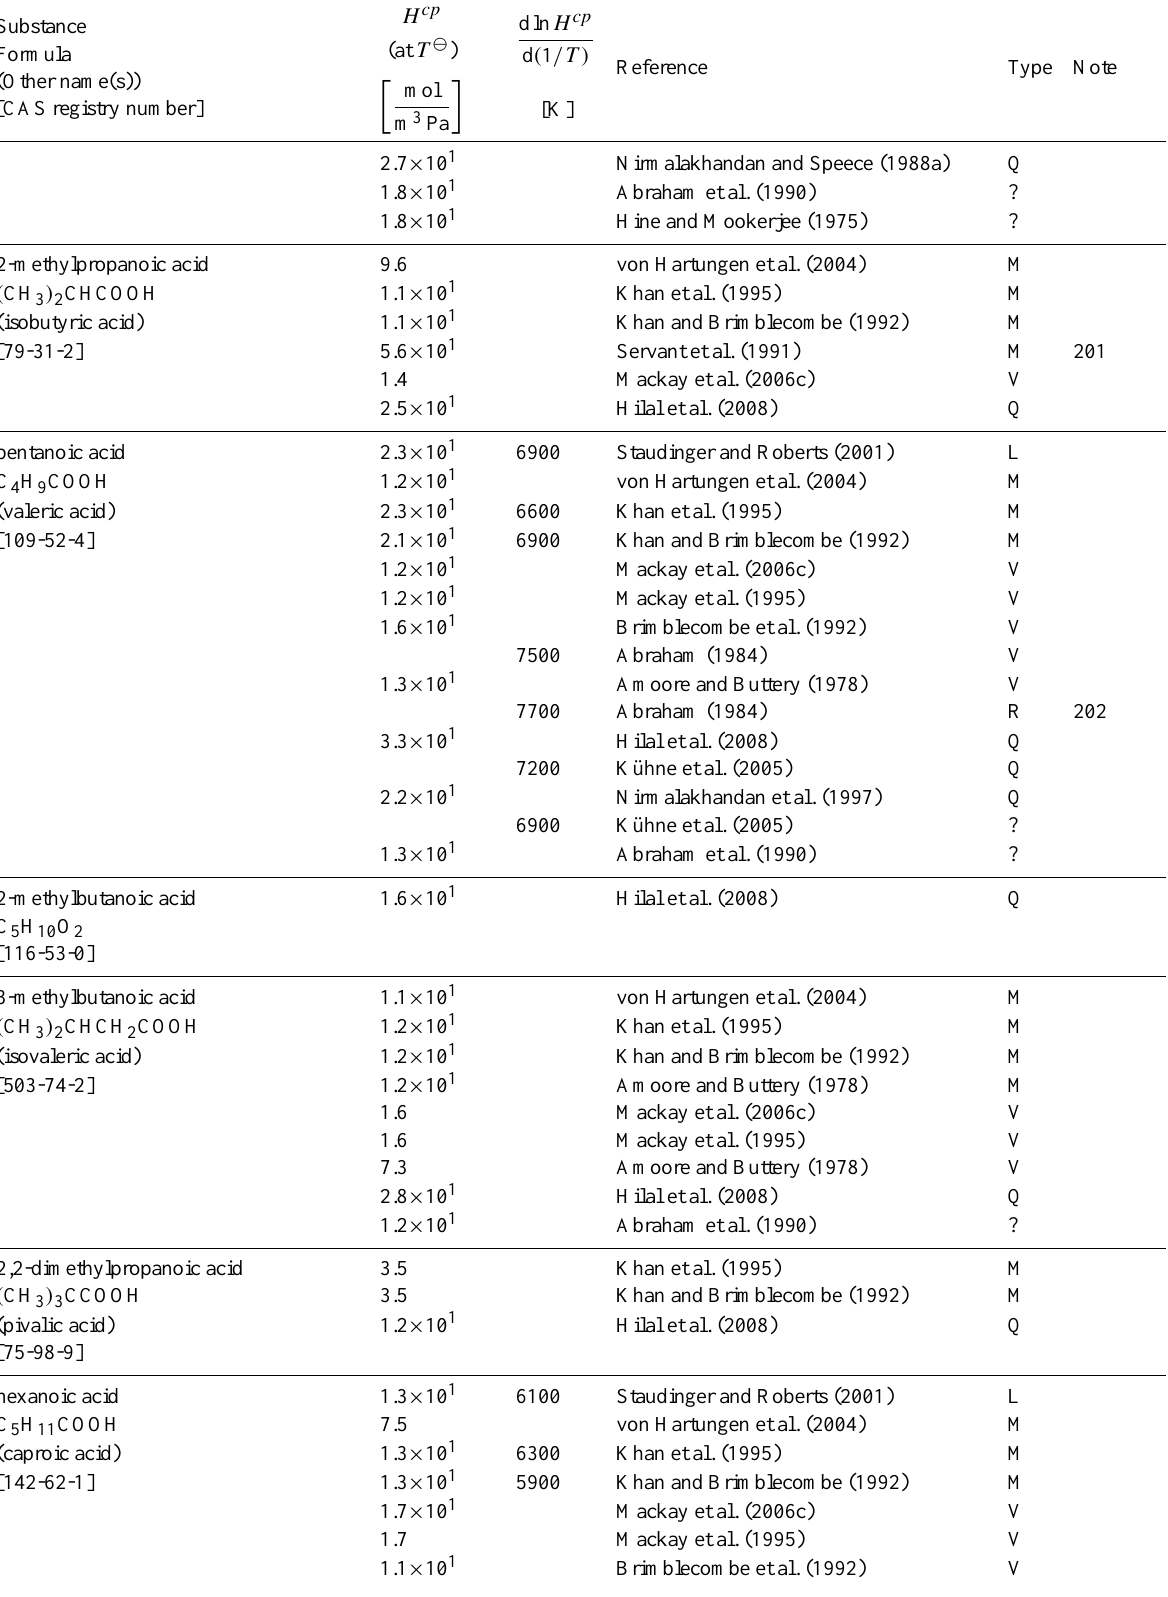
Table 6: Henry’s law constants for water as solvent